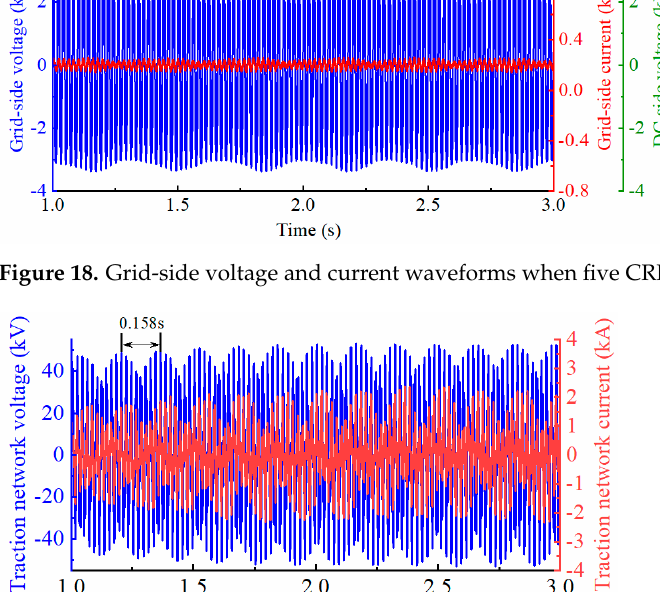
Figure 18. Grid-side voltage and current waveforms when five CRH5s are connected.